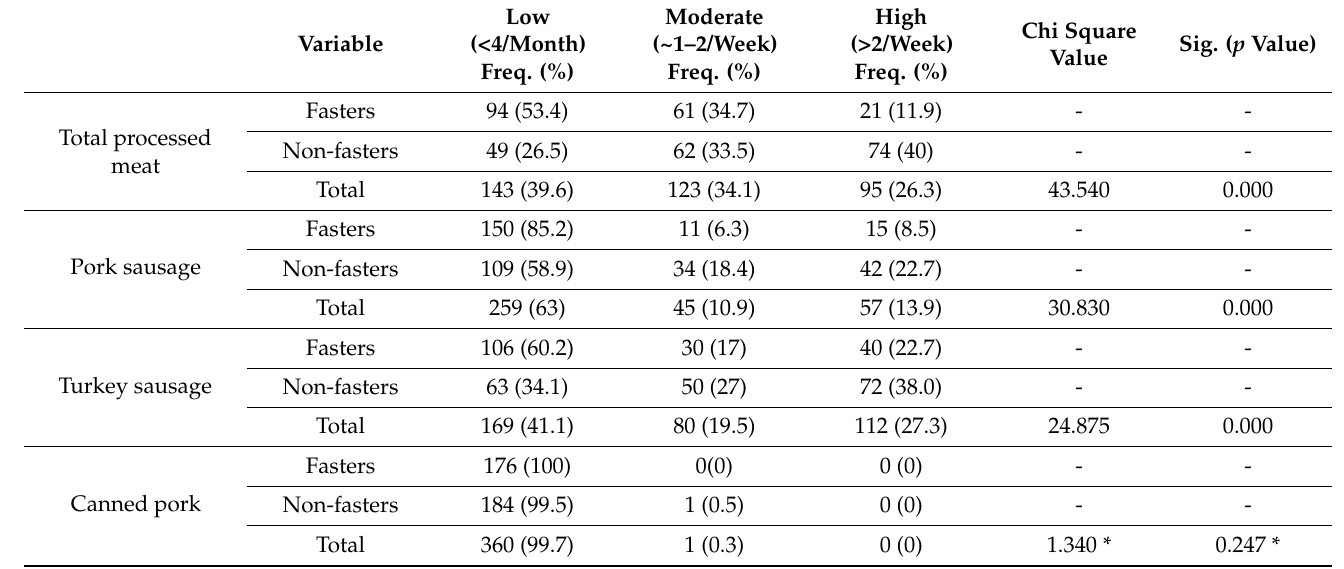
Figure 4. Bar chart for total processed meat intake between fasters and non-fasters. Table 5. Results for processed meat